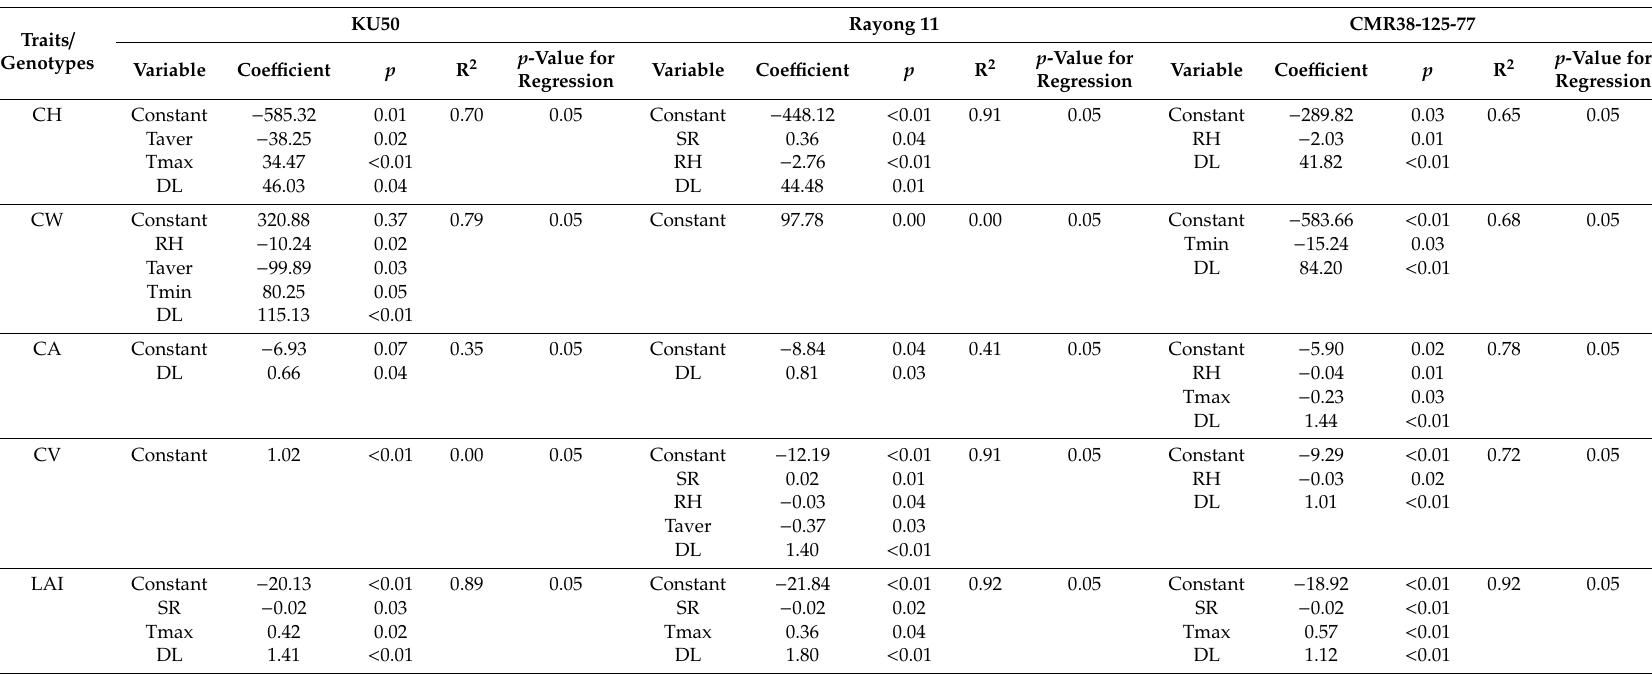
Table 6. Stepwise regression analysis for canopy traits and climatic factors for three cassava genotypes planted in November